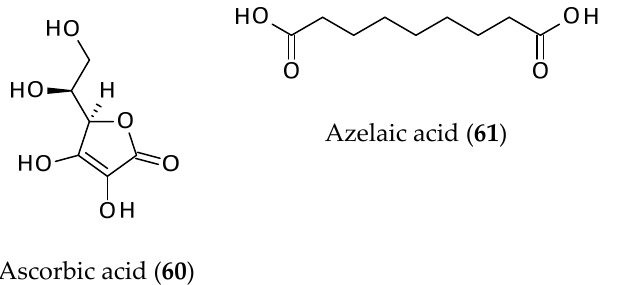
Figure 10. Ascorbic acid and azelaic acid from Alternanthera philoxeroides.